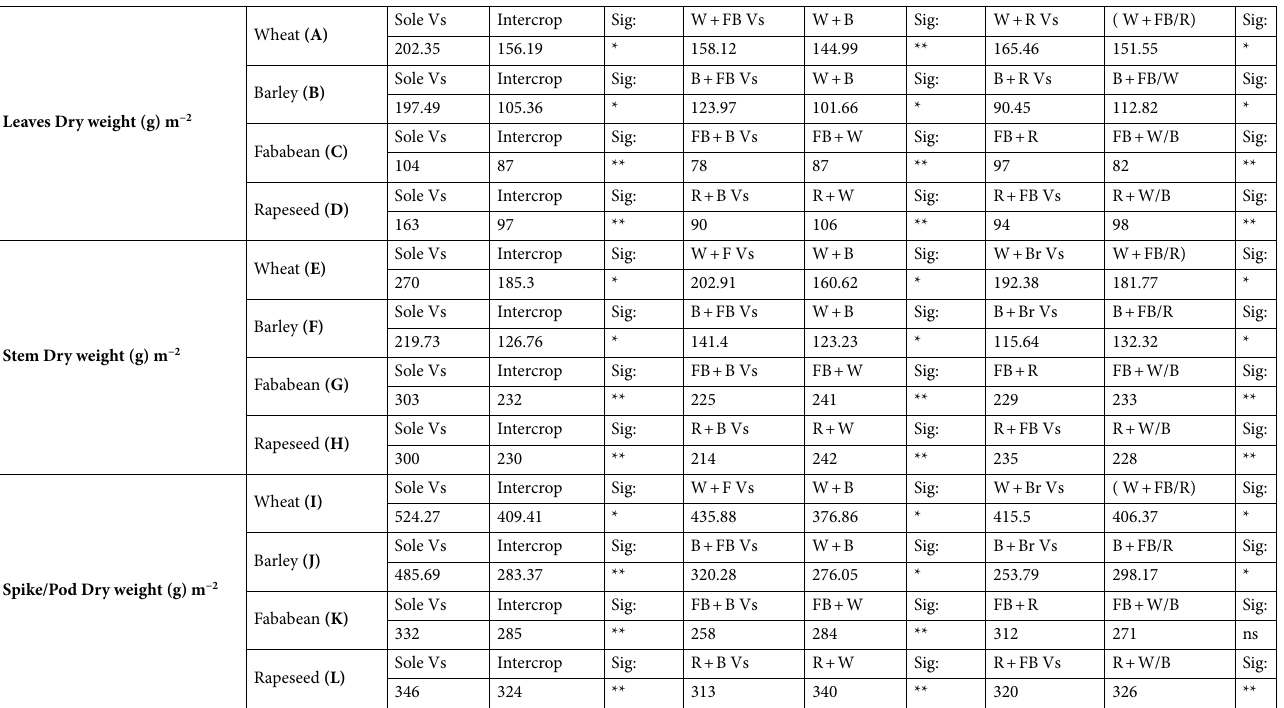
Table 4. Pre-planned comparison of different intercropping systems at physiological maturity of winter crops as affected by intercropping and irrigation regimes. Where *, ** stands for significant at 5 and 1% level of probability, respectively. W, B, FB and R, stand for wheat, barley, fababean and rapeseed, respectively. Means in the same category are not significantly different if followed by at least one common letter at ( P ≤ 0.05)